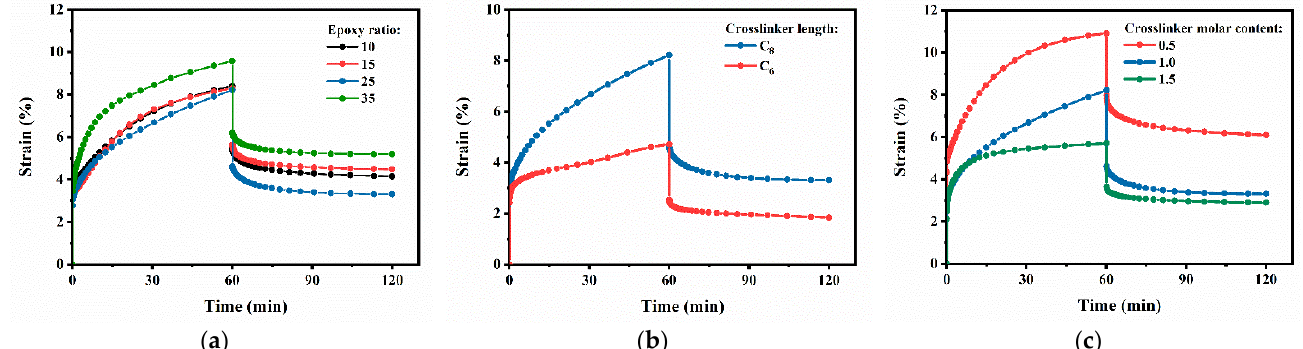
Figure 10. Creep recovery curves for PB vitrimers at 150 °C with the modification of network parameters: ( a ) epoxy ratio, ( b ) crosslinker length, and ( c ) crosslinker molar content.